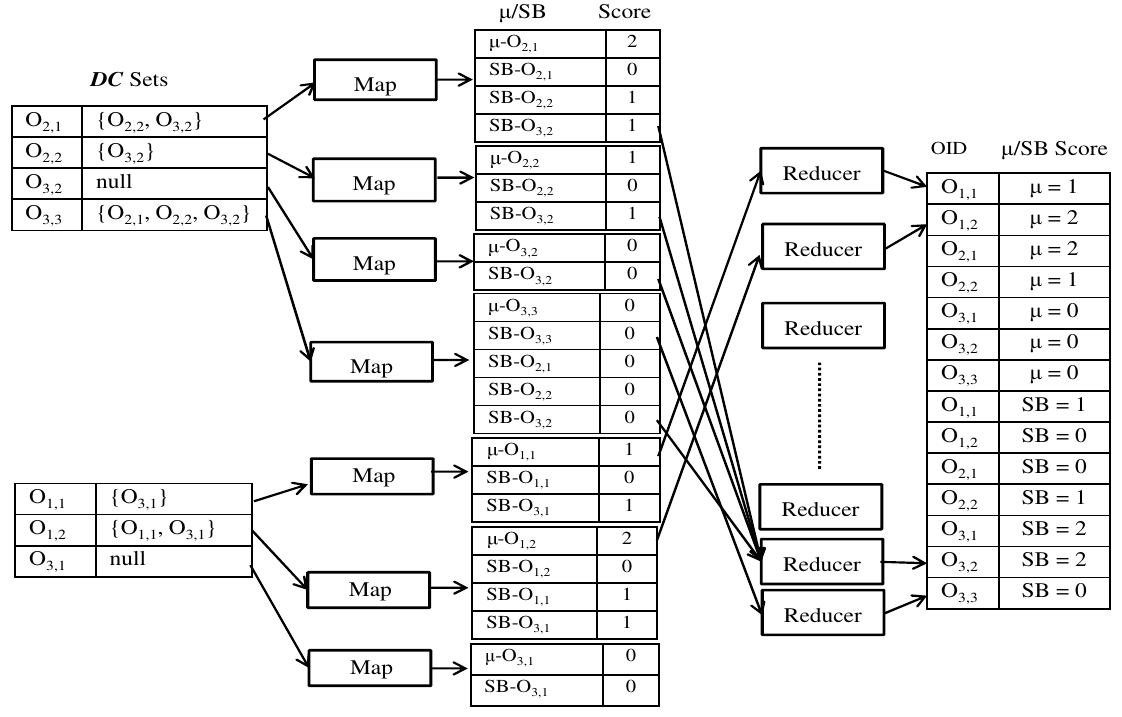
Figure 7. Skyband and top- k dominating